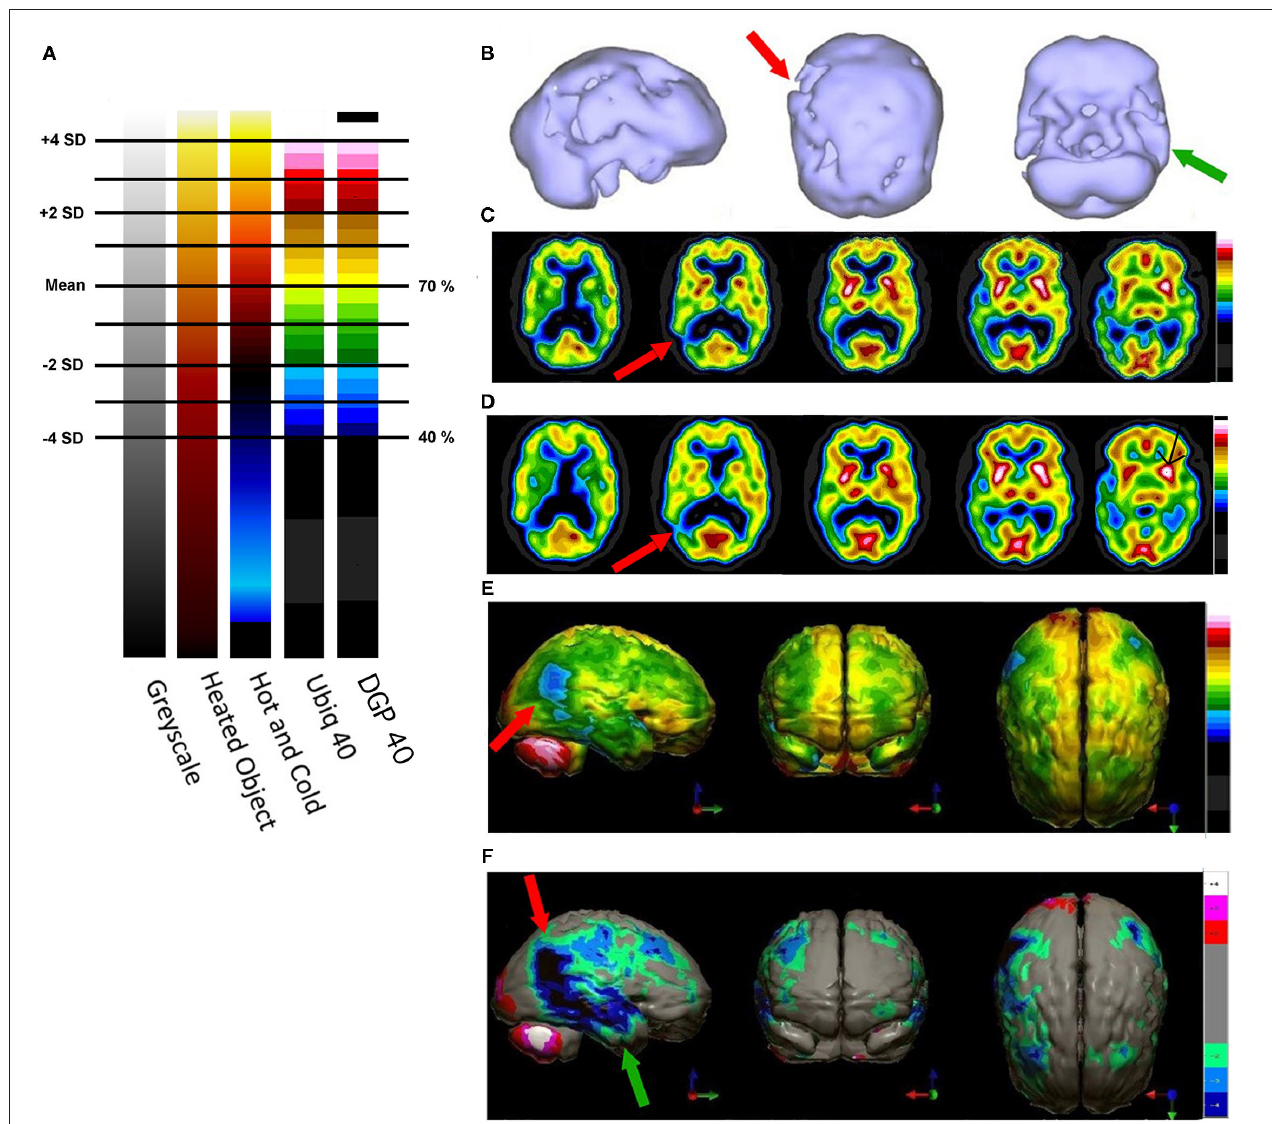
FIGURE 5 | (A) Various commonly used color scales and a greyscale are displayed. The mean cerebral perfusion in the human brain is 70% of the maximal flow with a standard deviation (SD) of 8.35%. The mean and ± 1 and 2 SD are indicated. A change of ± 2 SD is unlikely to be appreciated in greyscale but can be readily distinguished in Heated Object and Ubiq40 color scales. An increase of 2 SD can be distinguished in Hot and Cold color scale, but a decrease of 2SD or less would not be discernable. A 1 SD increase or decrease would be difficult to discern in greyscale, Heated Object and Hot and Cold color scale, but are readily detected in Ubiq40 and DPG40. (B) A 58-yr-old female was struck on the right parietal region by a heavy object with loss of consciousness of ∼ 2h. Perfusion SPECT scan was performed 7 years after the injury with 99m Tc-HMPAO and a dual-head gamma camera. SPECT data can be displayed in 3-D representations that facilitate the identification of large, diffuse, or subtle lesions. Here, data is presented as an isocontour display wherein cortical areas which fall below 60% of the maximal cerebral blood flow are displayed as a depression or hole. The large parietal defect is apparent on the right (red arrow), as well as bilateral temporal lobe hypoperfusion (green arrow). (C) 4mm horizontal sections illustrate decreased perfusion in the right parietal region (red arrow). The color scale is the Ubiq40. (D) 4mm horizontal sections illustrate decreased perfusion in the right parietal region (red arrow). The color scale is the DPG40. Note the black spot at the point of highest perfusion in the left thalamus (black arrow). (E) 3-D representation utilizes the Ubiq40 color scale. The right parietal defect appears as an area of blue and green (red arrow). (F) The patient’s data is compared to a normative database ( N = 68). A map of statistically significant differences can be generated using the Oasis software by Segami, Inc. Here, the color scale indicates gray for areas that do not differ significantly from the normative database. In contrast, areas of green, light blue, and dark blue represent areas of more than 2, 3, and 4 SD below the mean perfusion of the normative database, respectively. Statistically significant increases in perfusion are illustrated in the red color scale. The parietal lobe injury (red arrow) and the contra-coup injury are easily visualized, along with more diffuse penumbra injury and bilateral lateral temporal lobe hypoperfusion (green arrows).